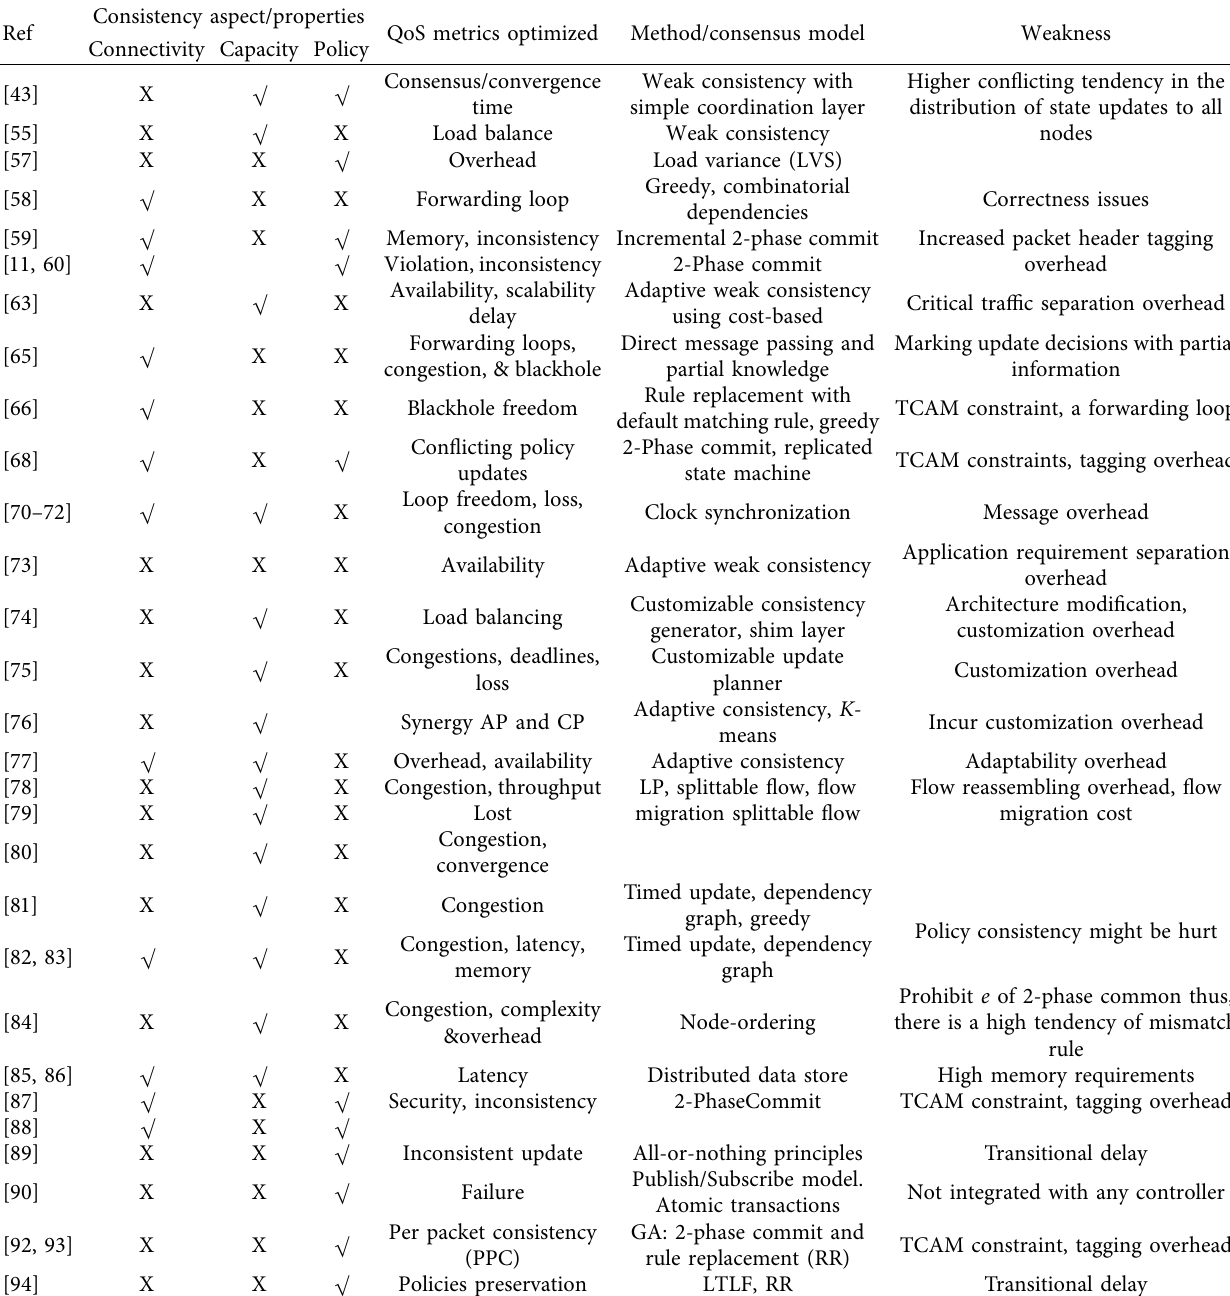
Table 4: Comparison of related works on dmCP